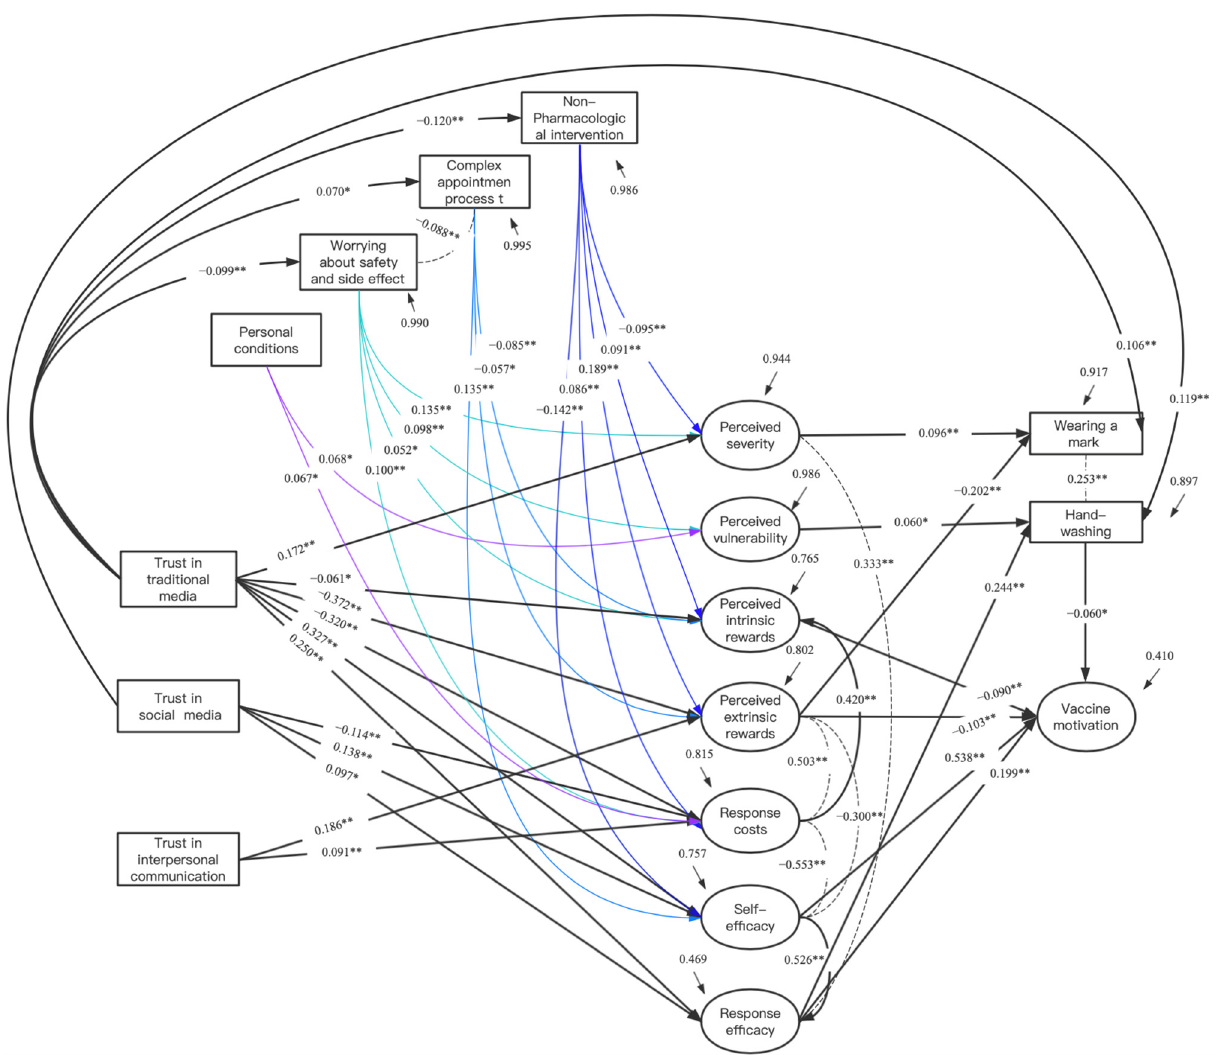
Figure 1. Structural equation modeling of different media trust and PMT variables. ** p < 0.001,* p < 0.05. Traditional media trust had a direct negative impact on both the “advocation for NPI” ( β = − 0.120, p < 0.001) and the “worrying about safety and possible side effects” ( β = 0.099, p < 0.001) in vaccine hesitation and had a direct positive impact on the “limited by